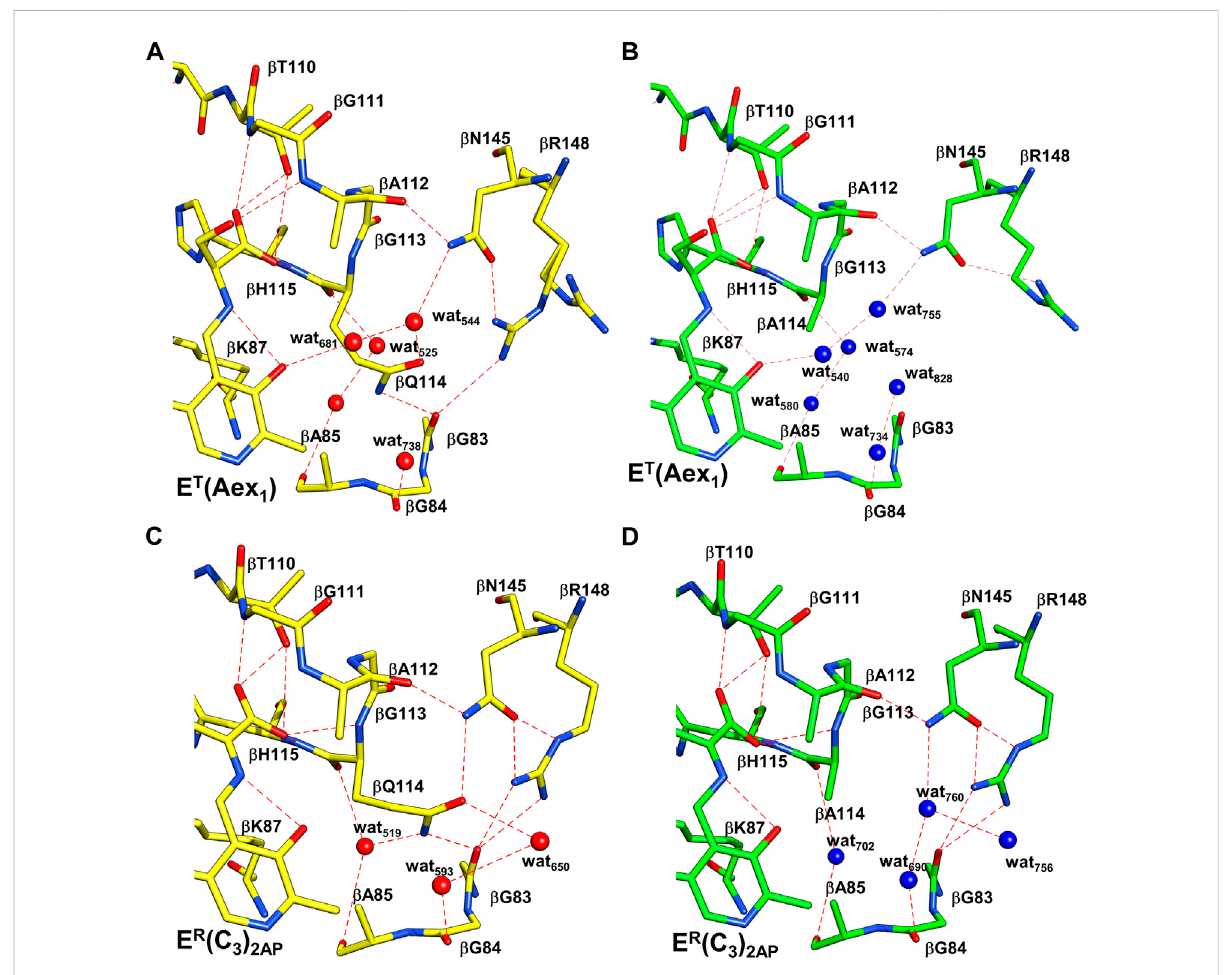
FIGURE 10 Comparison of the x-ray structures of T and R β -site conformations. Coloring scheme: WT structures, carbons yellow and waters red; β Q114A structures, Carbons green and waters blue. H-bonding interactions are shown as red dashes. (A,B) , WT and β Q114A E T (Aex 1 ) complexes (PDB ID: 6DZ4, 6DZO, respectively). (C,D) , WT and β Q114A E R (C 3 ) 2AP complexes(PDB IDs:4HPJ and6O1H).The Q to A mutation in Tcomplexes (A,B) causes minor disruptionsoftheH-bonding network with watersand theneighboringproteinresidues.TheRcomplexes (C,D) showlarger differences, the H-bonding interactions among β Q114, β N145 and β R148 are lost. These changes are virtually the same in the closed structures of the E R (A – A) complexes (not shown). Figure redrawn from Ghosh et al.